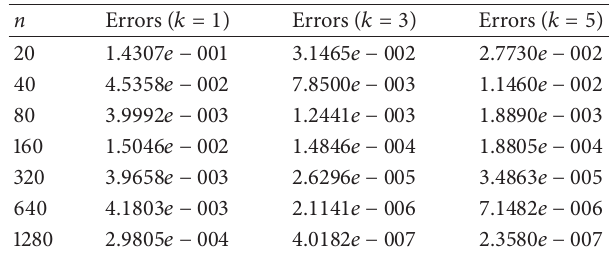
𝜋/3 | sin 30𝑥|𝑑𝑥 by GLNMI. 0